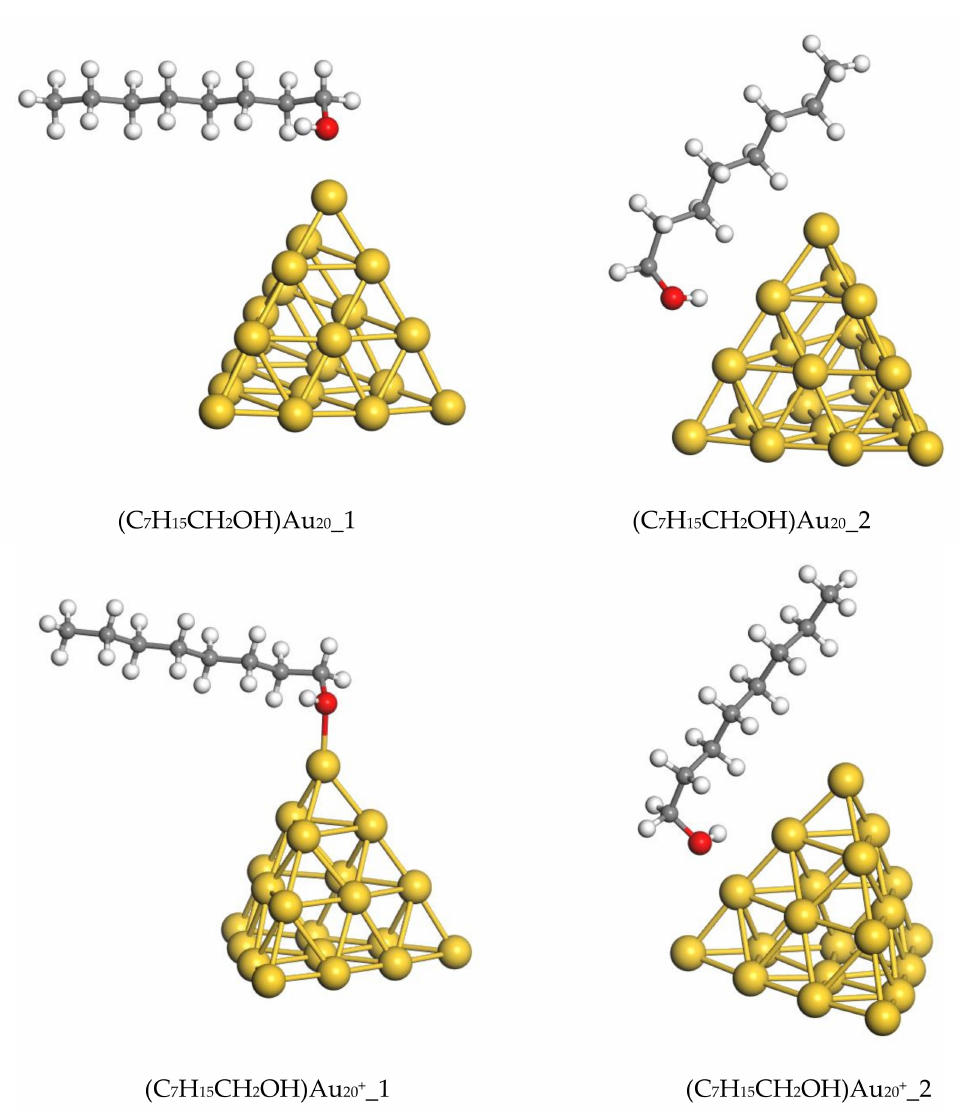
Figure 7. Optimized structures of n -octanol-Au 20 and n -octanol-Au 20 +